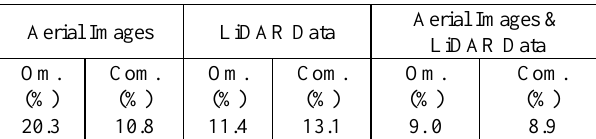
Table 3: Change detection errors of the algorithm for combining the three change detection methods for aerial images, LiDAR data and when these data are fused. Com. and Om. Stand for commission and omission errors